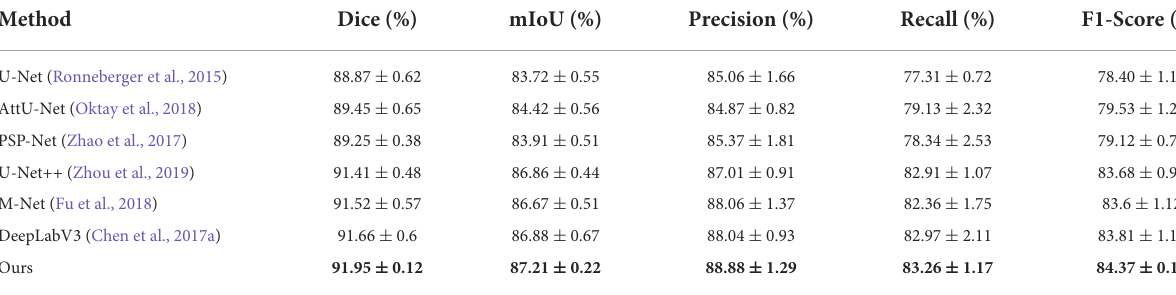
TABLE 1 Thyroid nodule segmentation performance of different segmentation approaches on the TNUI-2021 dataset.